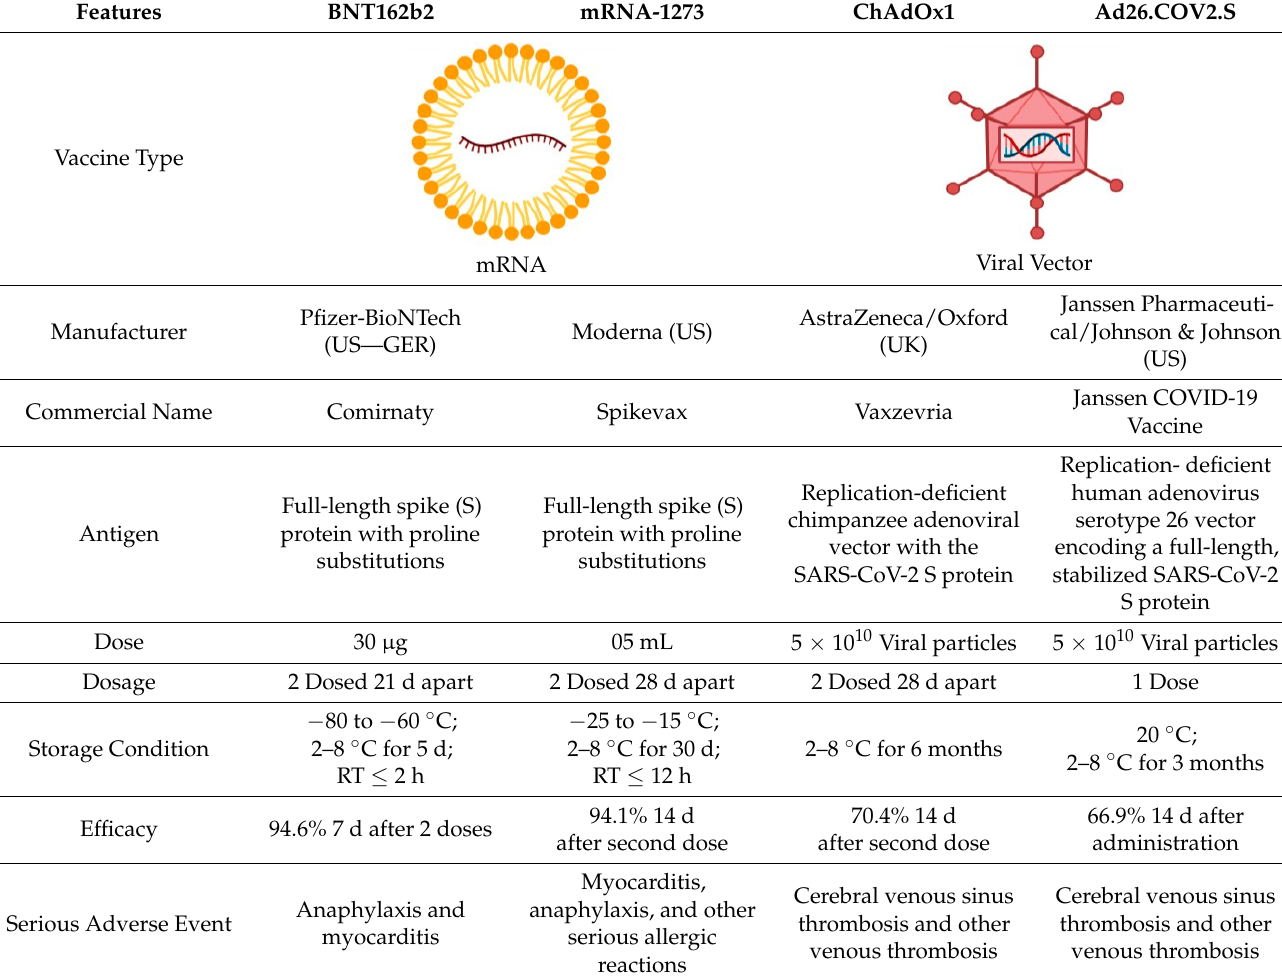
Table 1. SARS-CoV-2 EMA/FDA-authorized vaccines.